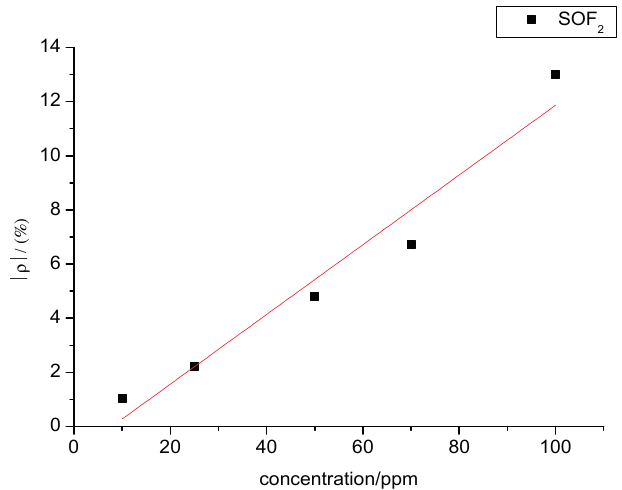
Figure 14. Linear relationship in the gas-sensing response of MWNT sensors to different concentrations of SOF 2 .